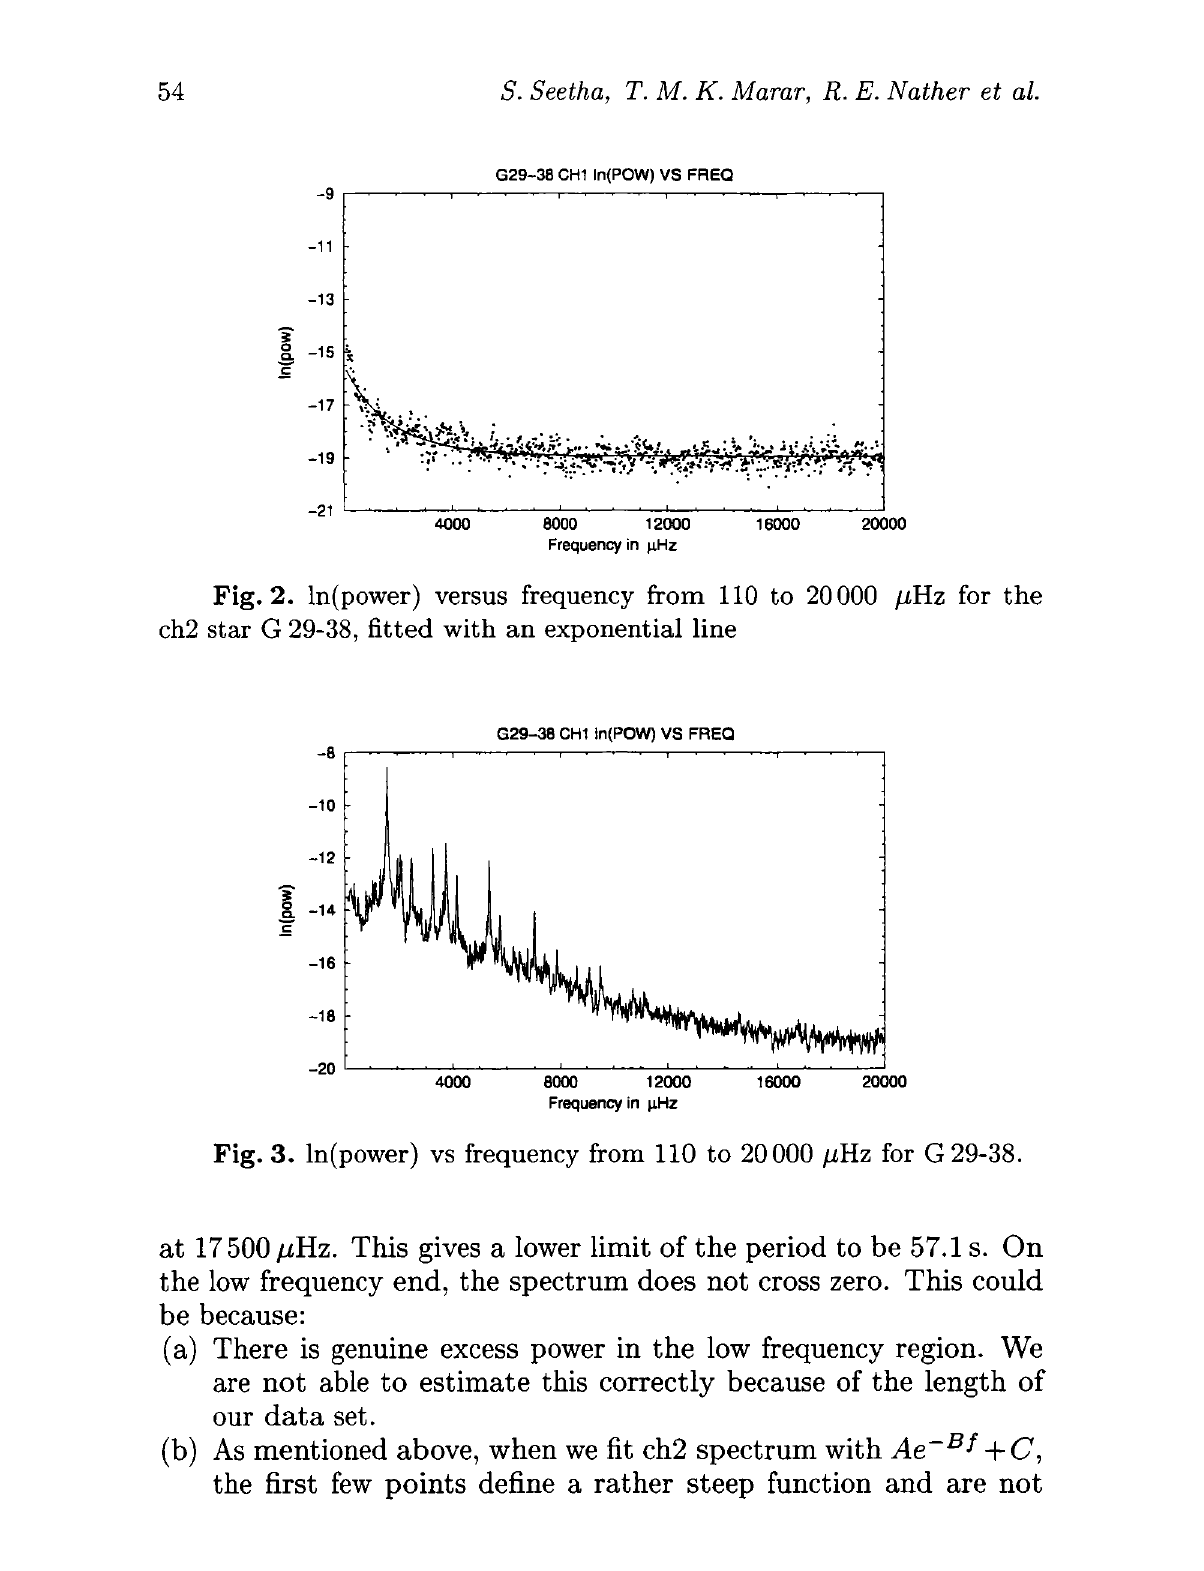
Fig. 3. ln(power) vs frequency from 110 to 20000 //Hz for G 29-38. at 17500 //Hz. This gives a lower limit of the period to be 57.1 s.